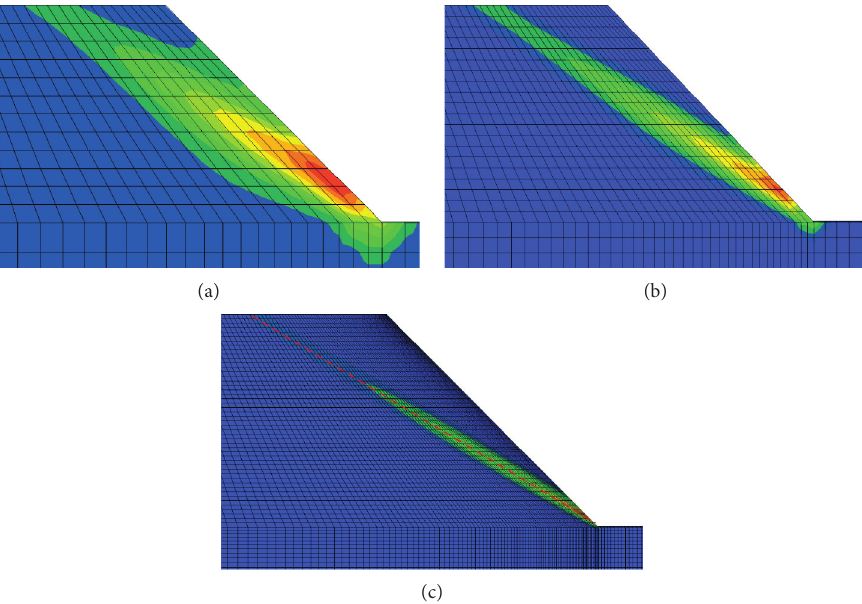
Figure 7: Incremental shear strains for different mesh discretization, (a) n � 675, (b) n � 1875, (c) n �